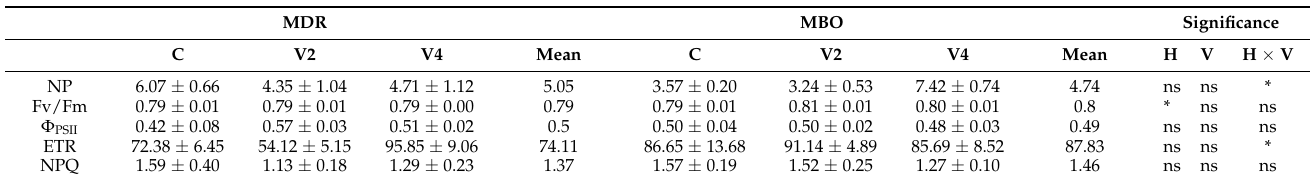
Table 1. Net photosynthesis (NP) in µ mol CO 2 m − 2 s − 1 , maximal PSII photochemical efficiency (Fv/Fm), quantum yield of PSII electron transport ( Φ PSII ), linear electron transport rate (ETR), non- photochemical quenching (NPQ), in plants of Ranunculus asiaticus L. hybrids MDR and MBO, obtained by three preparation procedures of tuberous roots, only rehydration (Control, C), rehydration plus vernalization for 2 weeks (V2), rehydration plus vernalization for 4 weeks (V4). Week 8 from planting (vegetative phase). Mean values ± Standard errors; n = 5; ns and * indicate non-significant or significant difference at p ≤ 0.05. Conditions in the glasshouse of measurements in the light: